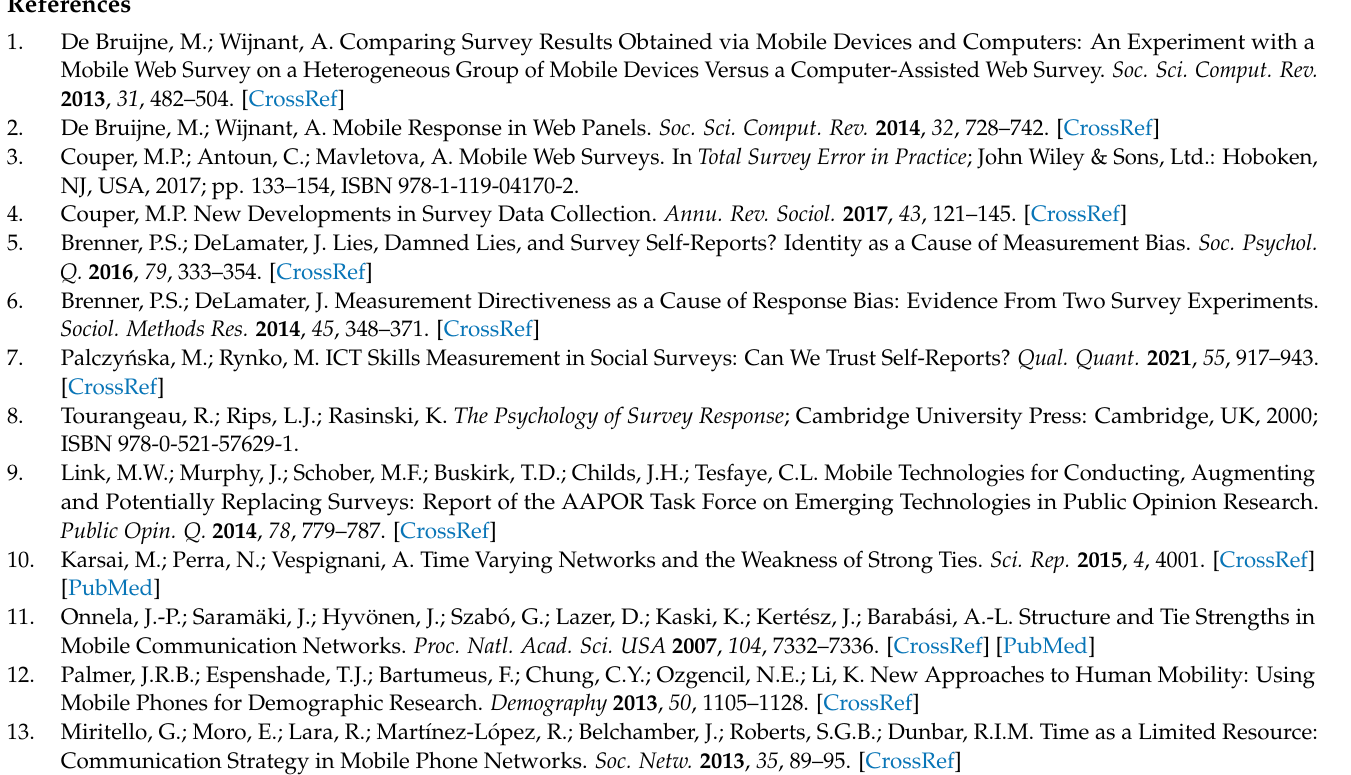
Figure A1. Comparison of responses for original vignettes vs. control vignette.